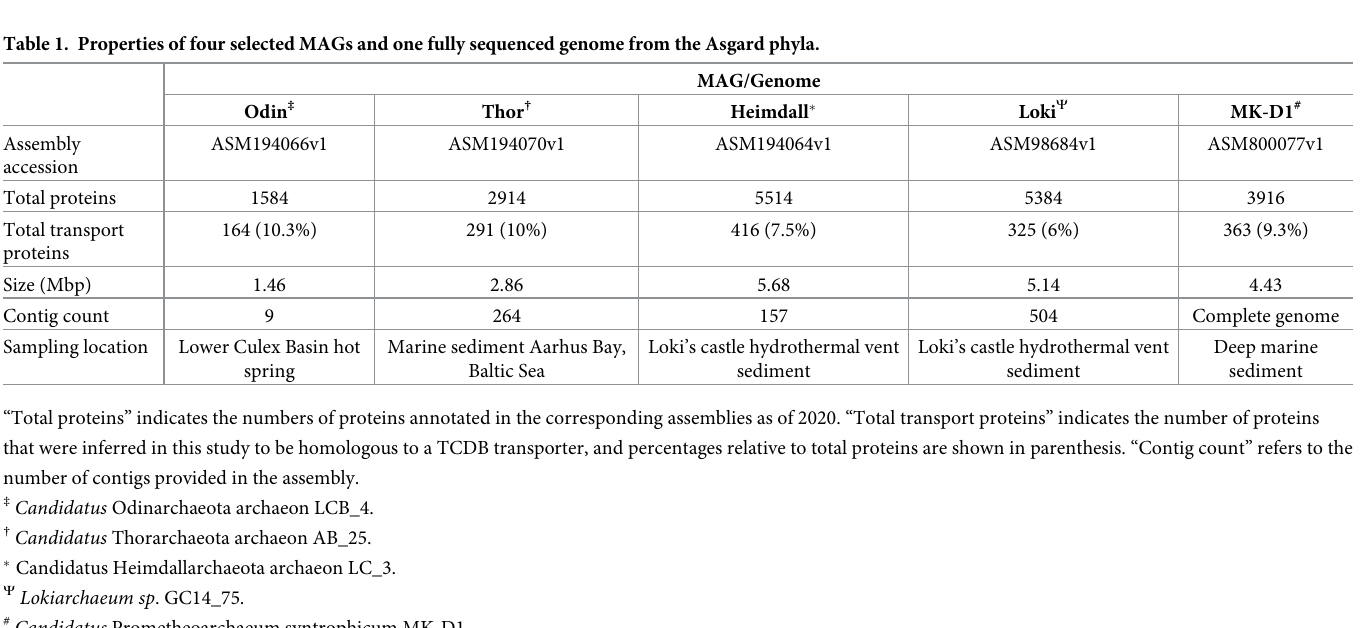
Table 1. Properties of four selected MAGs and one fully sequenced genome from the Asgard phyla.